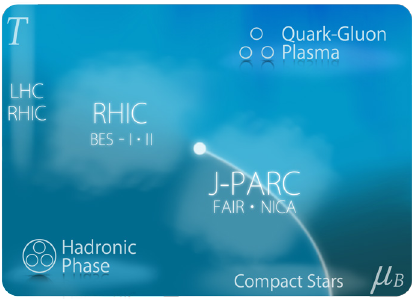
Table 1. Short summary of the charcteristics of the HIC and LAT.